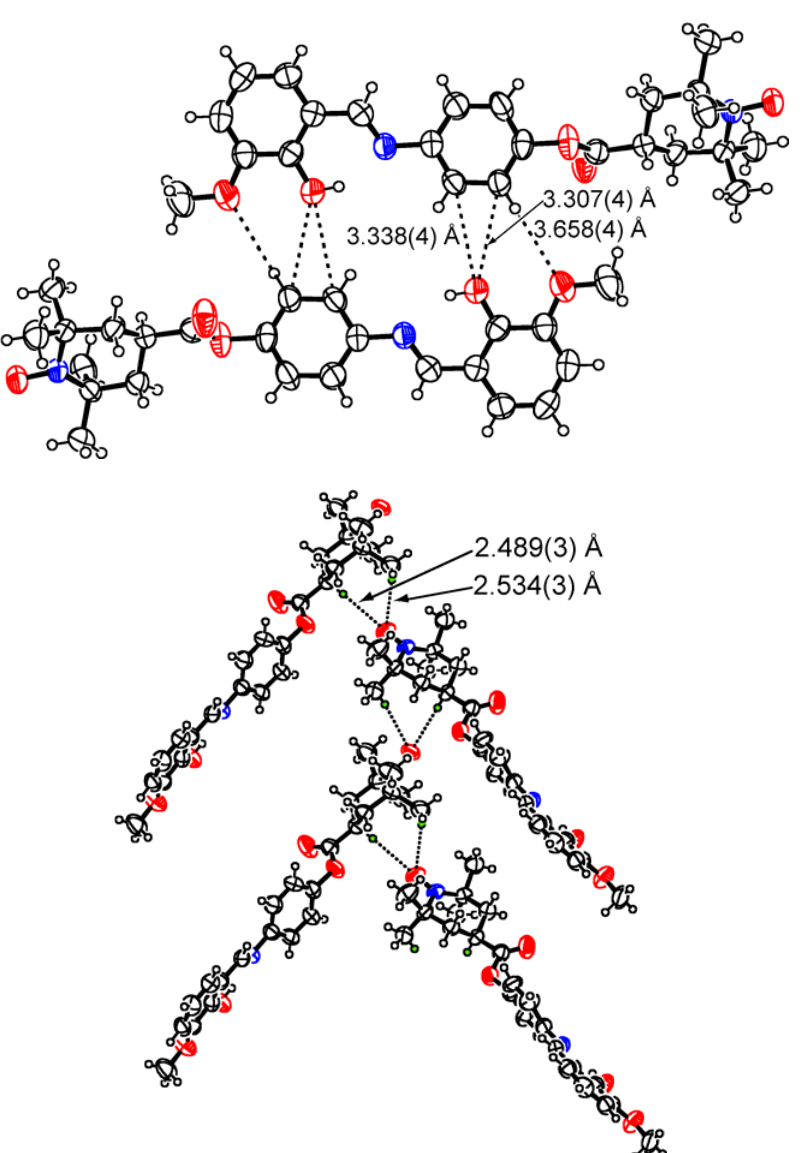
Figure 4. Molecular structures of 5 (two molecules are depicted) with indication of the short contacts found between the molecules (upper) and the crystal structure of 5